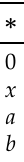
Table 1. Cayley table for the binary operation “ ∗